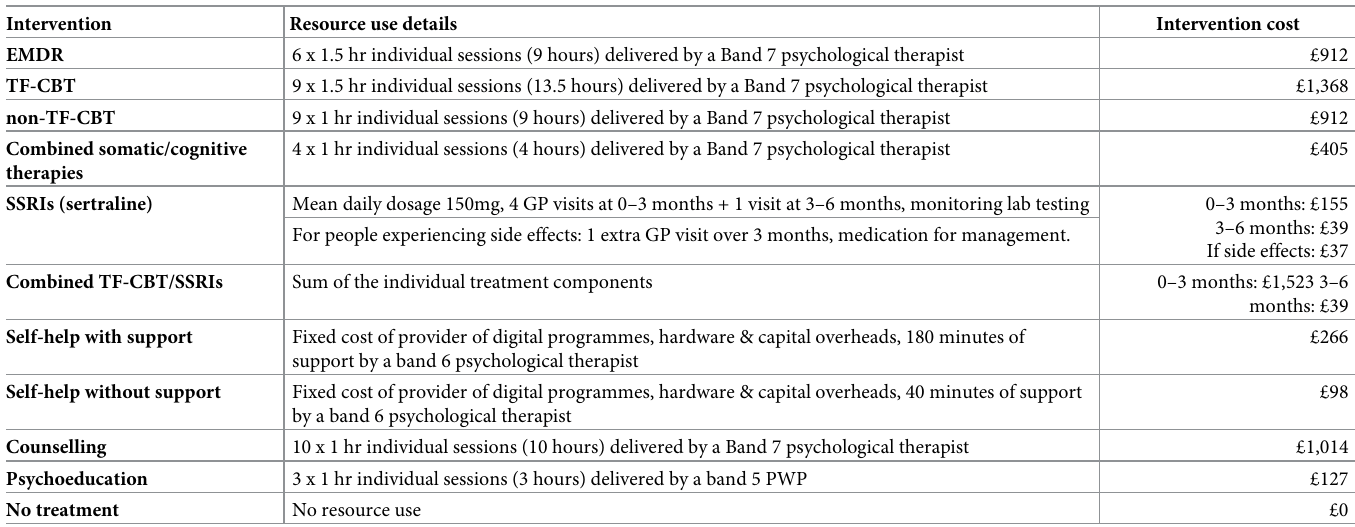
Table 1. Intervention costs of treatments for adults with PTSD (2017 prices). Intervention Resource use details Intervention